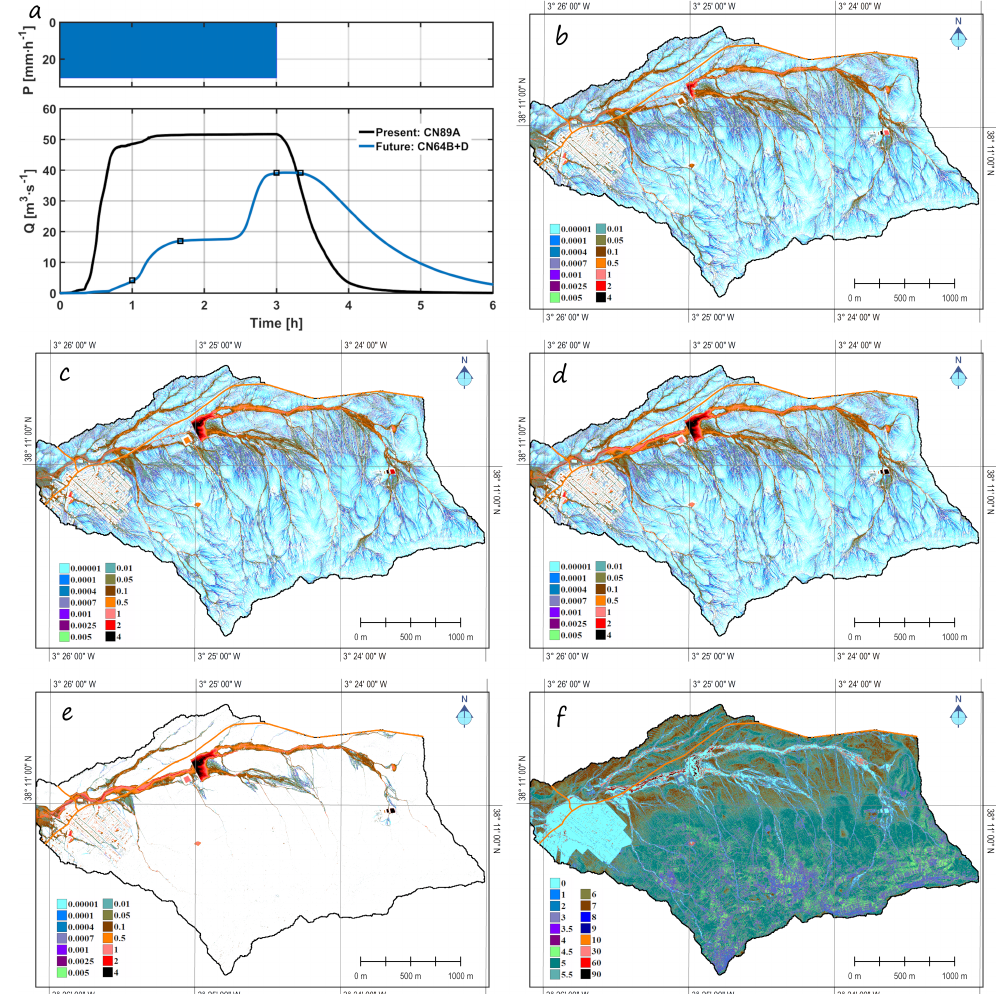
Figure 12. ( a ) Simulated hydrographs in the Manillas stream, near the town, for the current state (black) and the possible future (blue) after implementing the combined NbS B and D. ( b – e ) Snapshots of the simulated flow depth (in meters) with NbS B and D at t = 60, 100, 180, and 200 min corre- sponding, respectively, with the streamflows Q = 4.2, 17.6, 39.2, and 39.1 m 3 ·s − 1 (squares in panel a). ( f ) Maximum infiltration rate (in mm·h − 1 ) achieved at the end of the rain (i.e., t = 180 min) for the future scenario with NbS B and